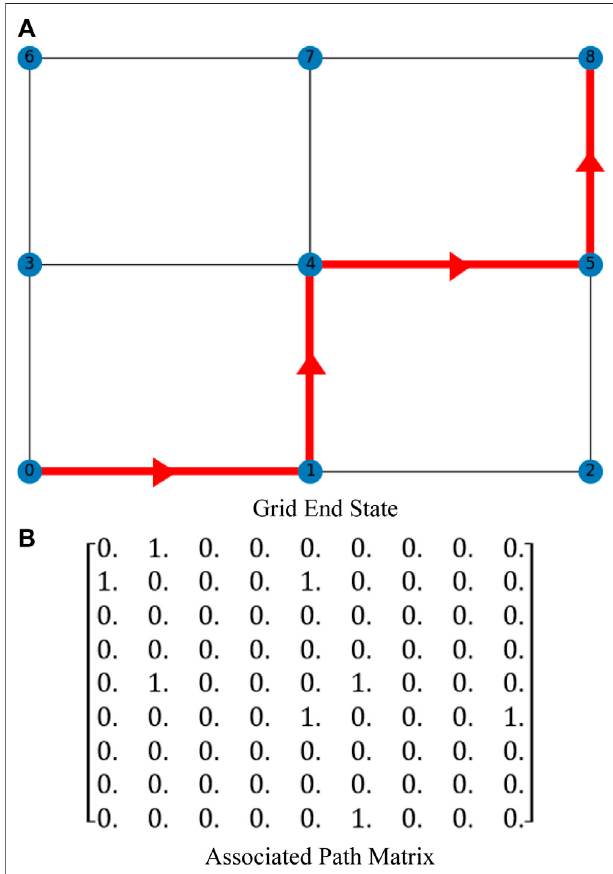
FIGURE 10 | Example output of LeastChanges. (A) Grid end state. (B) Associated path